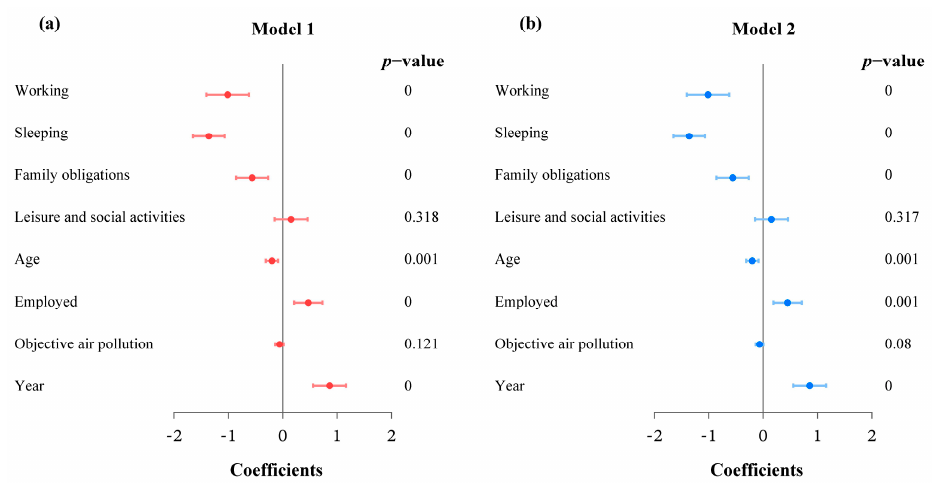
Figure 5. ( a ) Forest plot of some estimated coefficients in model 1 and ( b ) model 2.